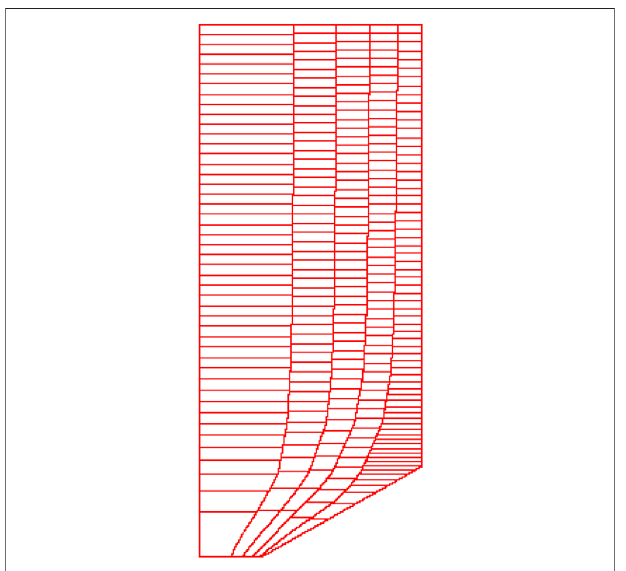
FIGURE 6 | Pebble- fl ow model used in PANGU simulation.